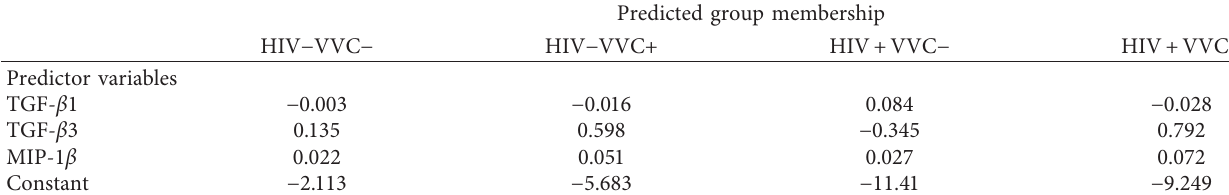
Table 3: Classification results: functions’